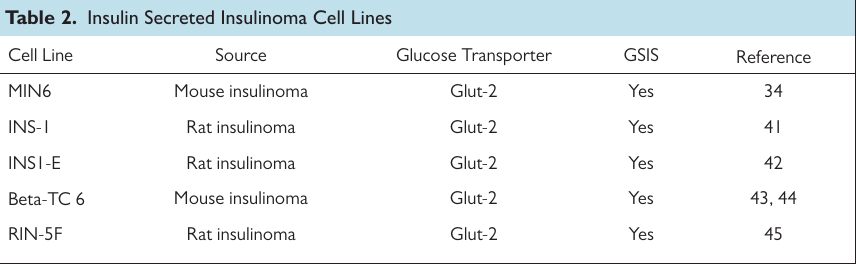
Table 2. Insulin Secreted Insulinoma Cell Lines Cell Line